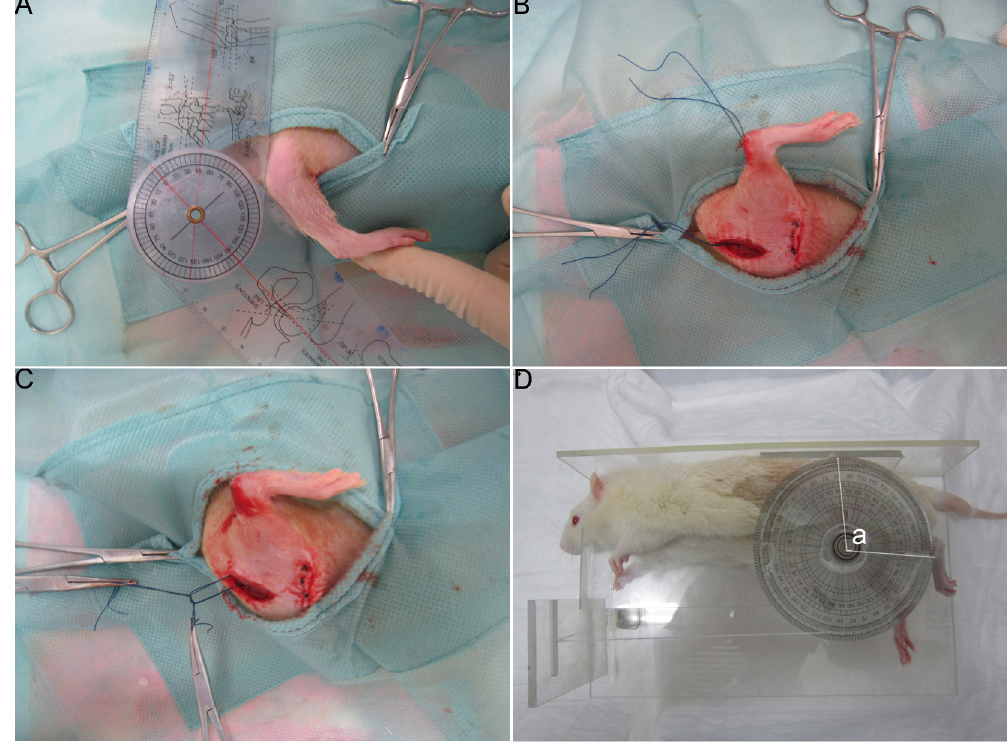
Figure 5. Rat model of joint contracture and measurement of the flexion contracture angle. ( A ) The knee was hyperextended to − 45° to disrupt the posterior capsule; ( B , C ) The knee joint was immobilized at 140° flexion with Ethibond Excel polybutylate-coated braided polyester sutures; ( D ) The flexion contracture angle was measured and determined as